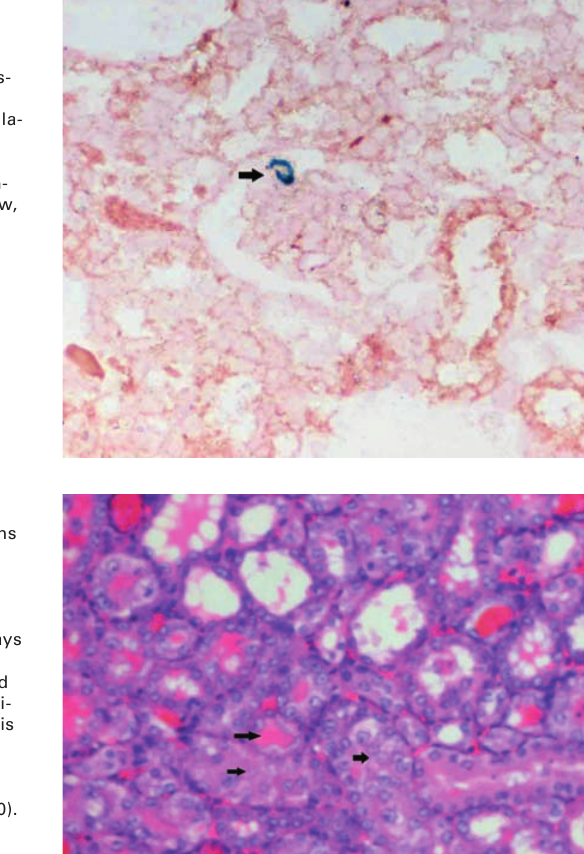
Histological sections of the kidney in group C (control group, phosphate- buffered saline in- jected only) at 4 days after injection of phosphate-buffered saline showing seri- ous tubular necrosis and intra-tubular casts. (arrows, Haematoxylin & eosin-stained,